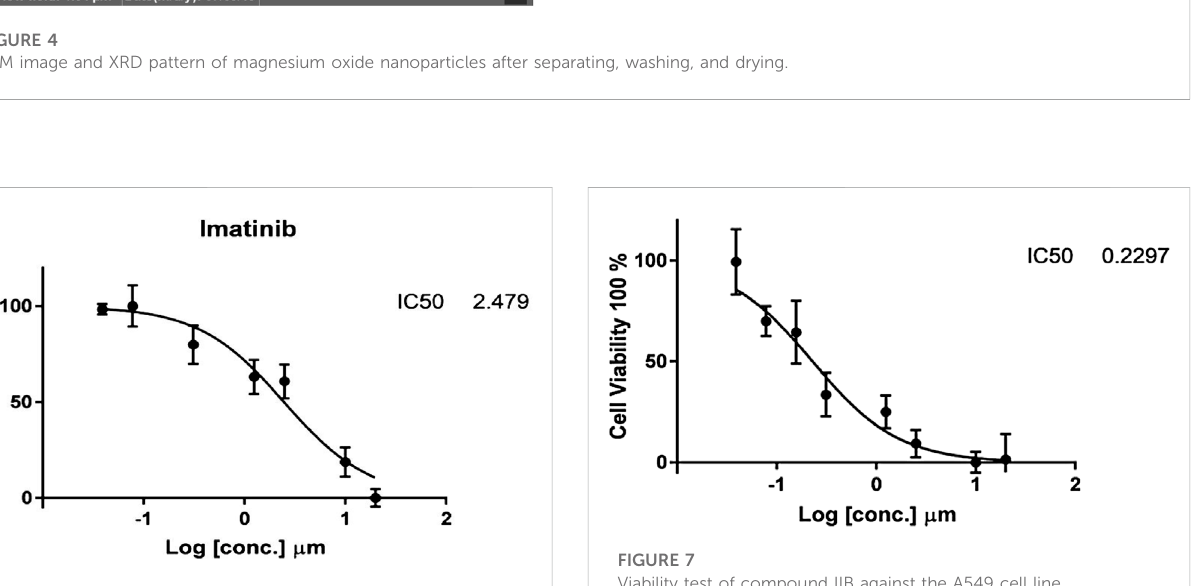
FIGURE 5 Viability test of imatinib against the A549 cell line.